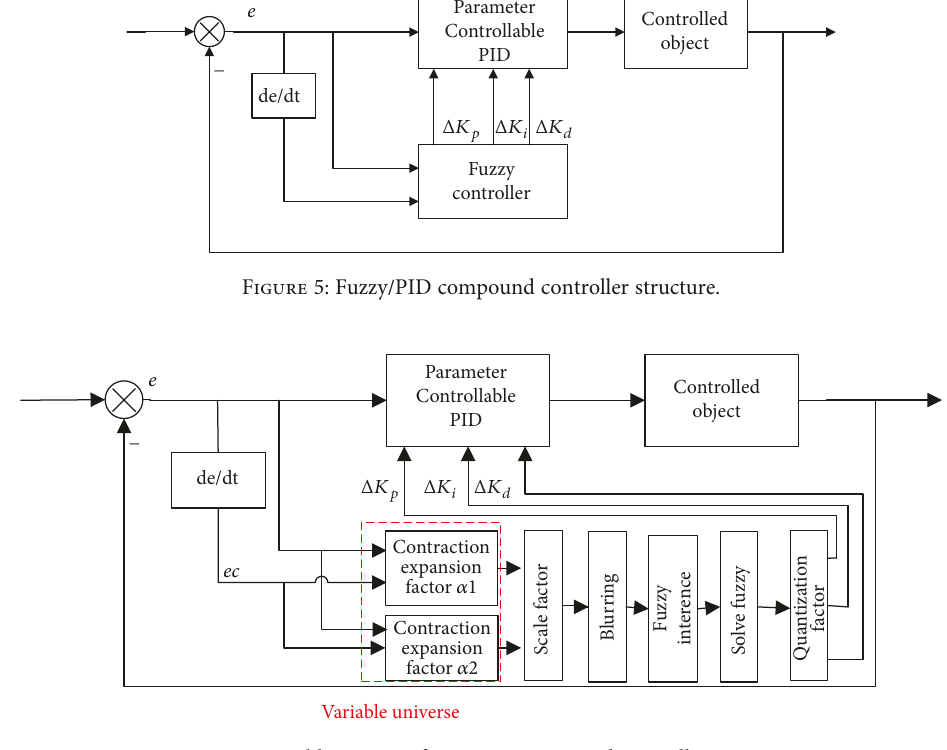
Figure 6: Variable universe fuzzy/PID compound controller